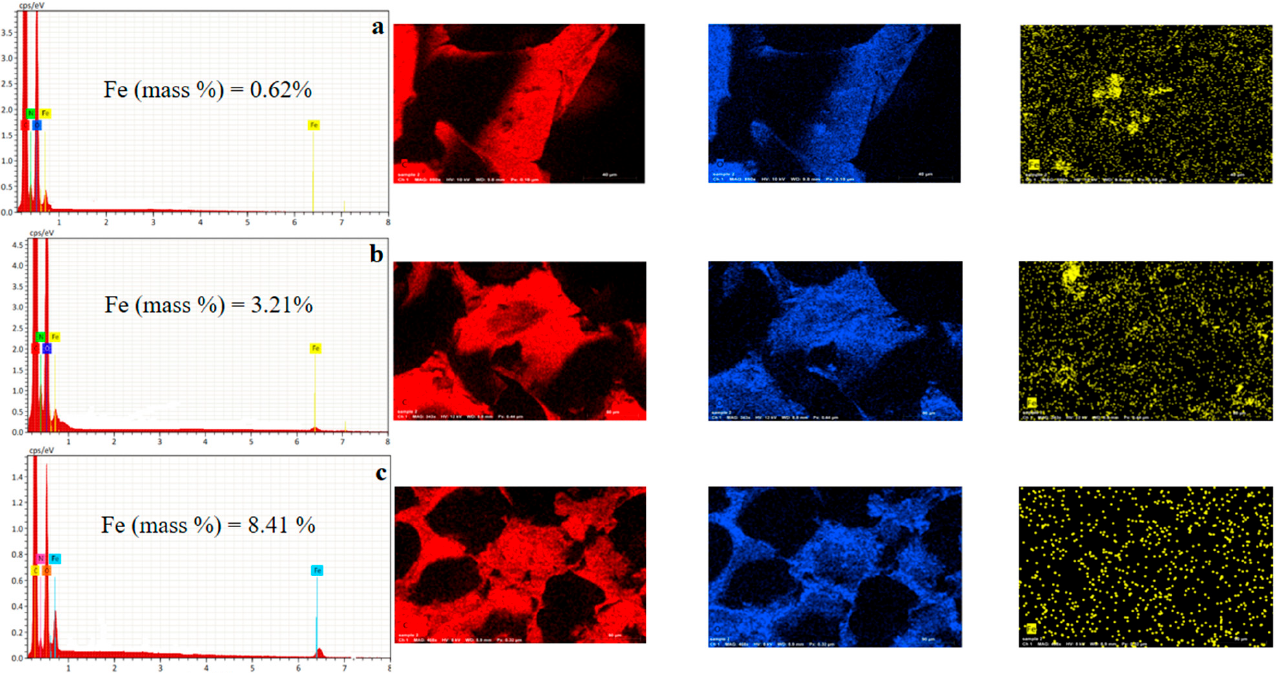
Figure 8. The EDX results and mapping for ( a ) P 1 MR20, ( b ) P 2 MR20, and ( c ) P 3 MR20.